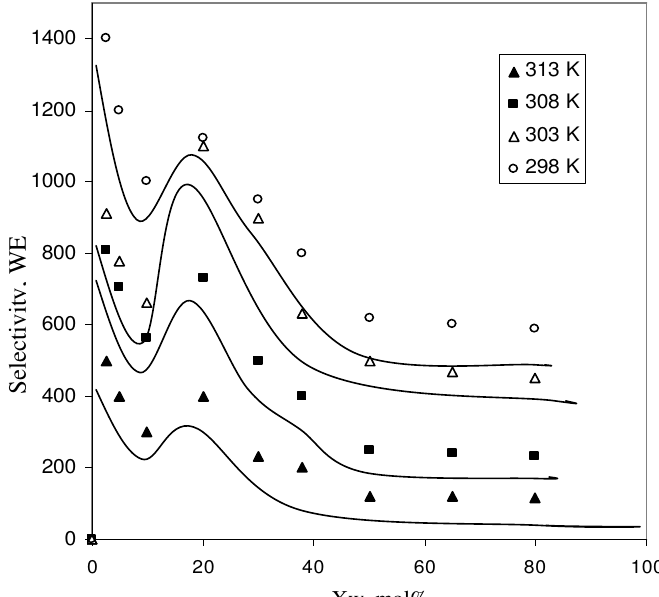
Figure 15. Evolution of ethanol-water selectivity with water feed composition (molar) using zeolite type-A.